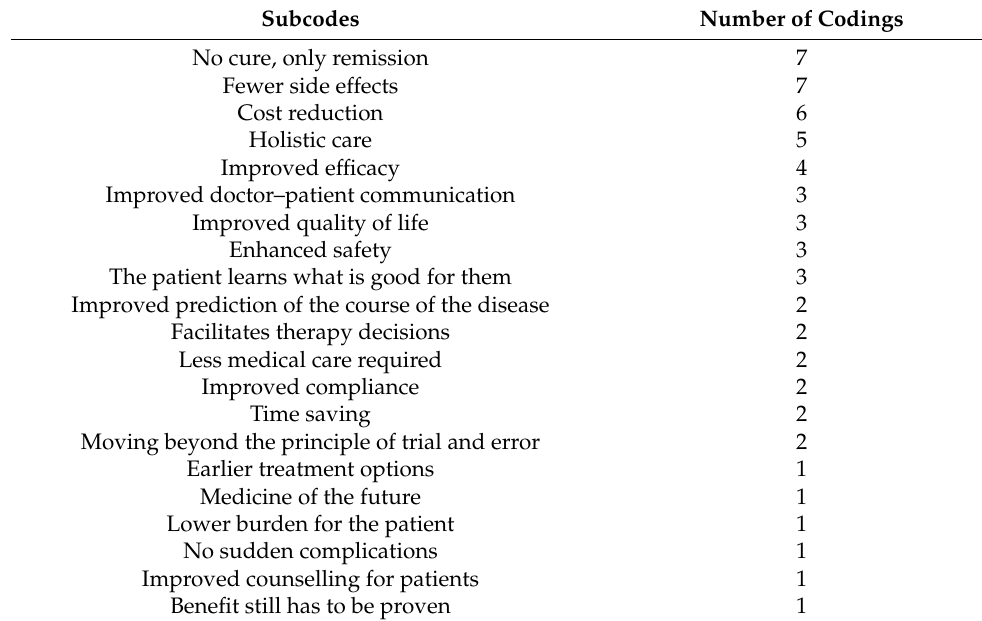
Table 4. Attributes and Benefits of